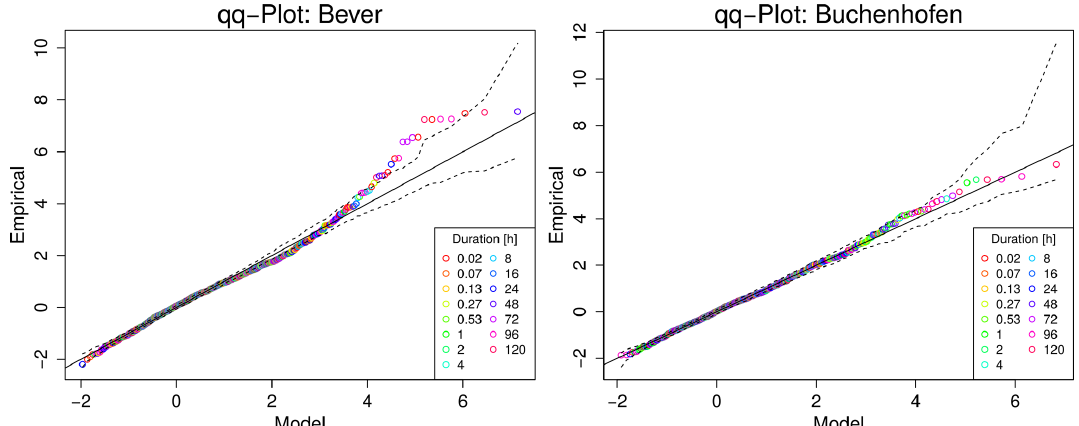
Figure D1. QQ plots for selected stations. Confidence intervals were obtained by simulating transformed Fréchet distributed values from the model distribution and extracting a 95%